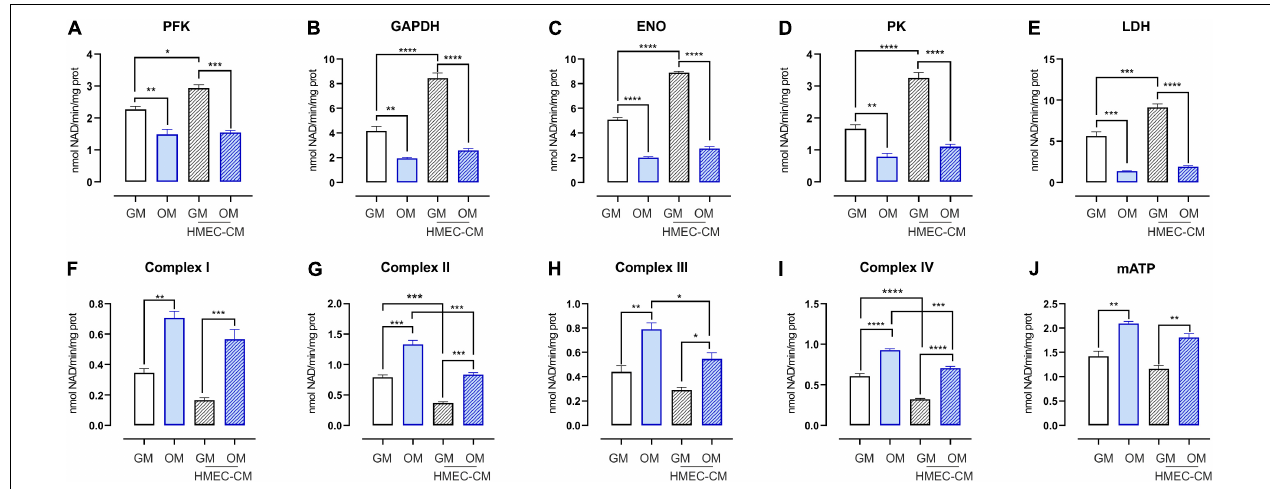
FIGURE 4 | Metabolic profile of SHED treated with CM from HMEC. (A–D) Activities of glycolytic enzymes in SHED-GM or SHED-OM treated or not with HMEC derived CM. Data represent means ± SEM, n = 3. For statistical analyses, ordinary one-way ANOVA with Bonferroni’s multiple comparison test was used. * p <